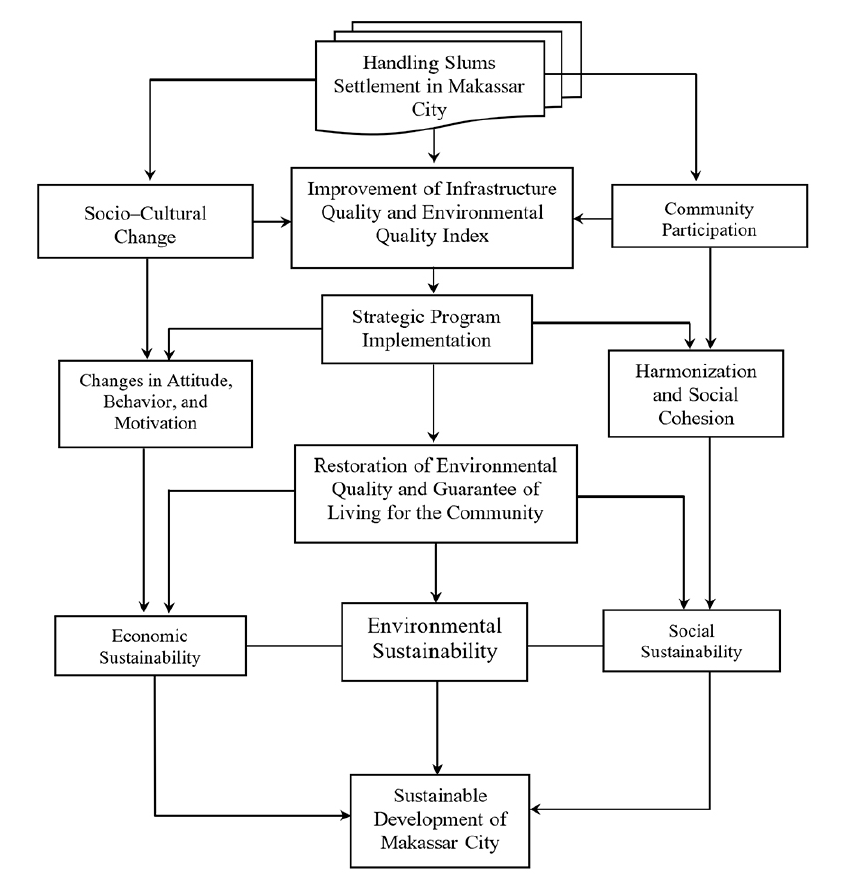
Figure 6. Handling of slum settlements and sustainable development of Makassar